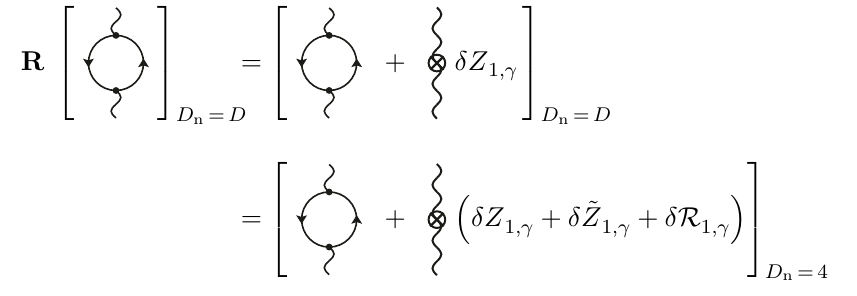
Figure 2 . Graphical representation of (4.21) for a renormalised QED selfenergy in D numerator dimensions and the relation (4.26) to its counterpart in D n = 4 dimensions. The indices (cid:11) = ( (cid:11) 1 ; (cid:11) 2 ), the external loop momentum q 2 and terms of